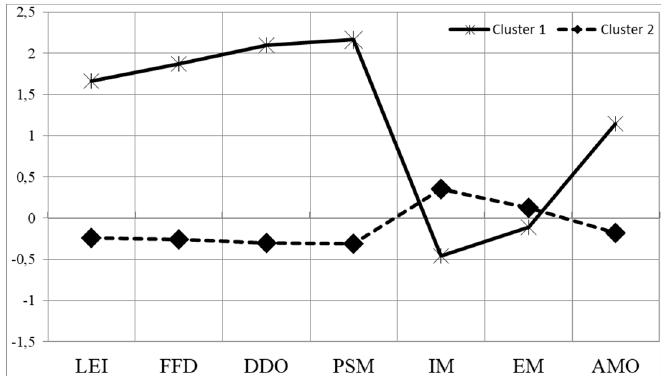
Figure 1. Motivational and disruptive behaviours profiles. Cluster 1: High disruptive behaviours profile; Cluster 2: Low disruptive behaviours profile. Z scores are represented on the vertical axis. On the horizontal axis are the scores of each subscale with the following abbreviations: LEI—Low engagement or irresponsibility; FFD—Fails to follow directions; DDO—Distracts or disturbs others; PSM—Poor self-management; IM—Intrinsic motivation; EM—Extrinsic motivation; AMO—Amotivation.